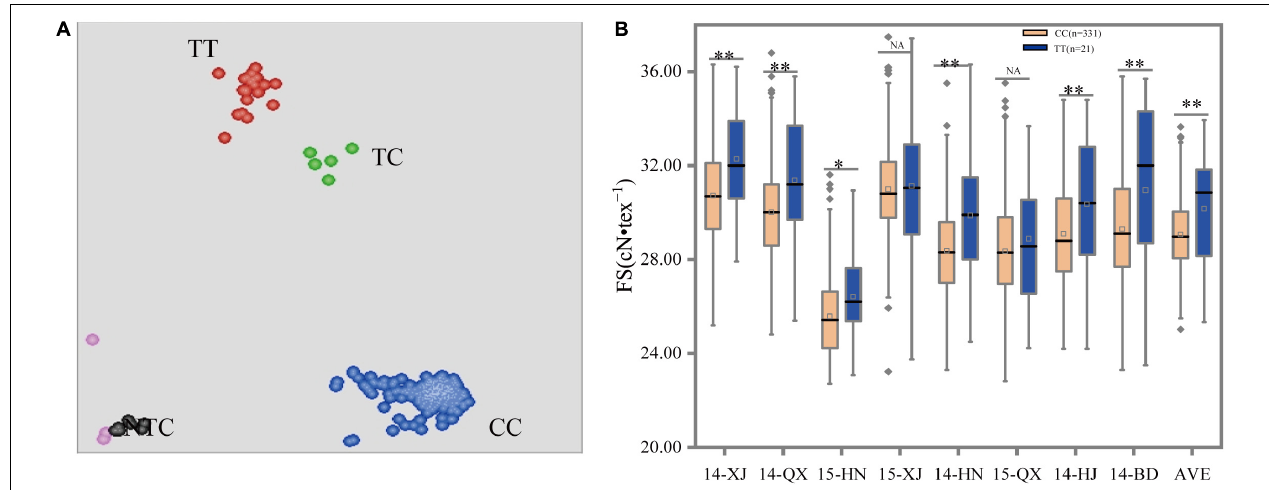
FIGURE 3 | Scatterplots and box plots for marker A07_72204443 (C/T). (A) Clustering of accessions on the X - (FAM) and Y - (HEX) axes. The red, green, blue, pink, and black dots represent the homozygous, heterozygous, homozygous, missing or failed data, and non-template control, respectively. (B) Allele effects were measured using different phenotypic data under eight environments. ∗ , ∗∗ , and NA indicate significant levels at P < 0.05, P < 0.01, and no significant difference, respectively.